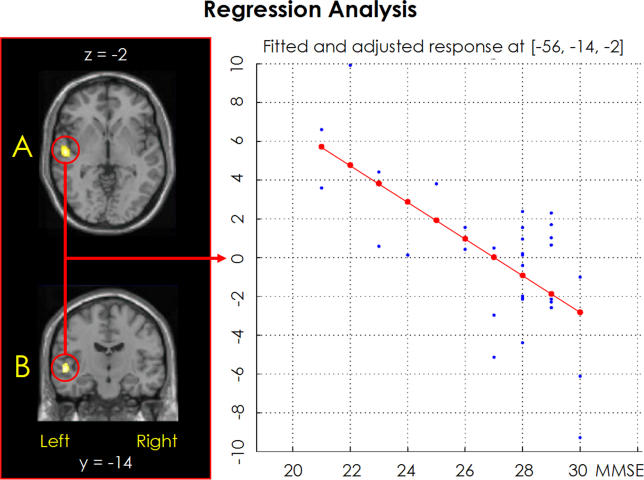
Positive Linear Regression of Auditory Cortical Deactivation with Cognitive Performance (MMSE) in All ParticipantsLeft: results are superimposed on a standard MRI template. Yellow indicates a significant relationship of cerebral deactivation with the MMSE: (A) axial slice, cranial aspect; (B) coronal slice, dorsal aspect (results are displayed at p < 0.005, for illustration purposes).Right: Regression analysis (red indicates regression line) of the fitted and adjusted rCBF response (blue points, arbitrary units) to active navigation in relation to the MMSE score at the position of the significant cluster (Talairach coordinates x, −56; y, −14; z, −2; p < 0.001, uncorrected).